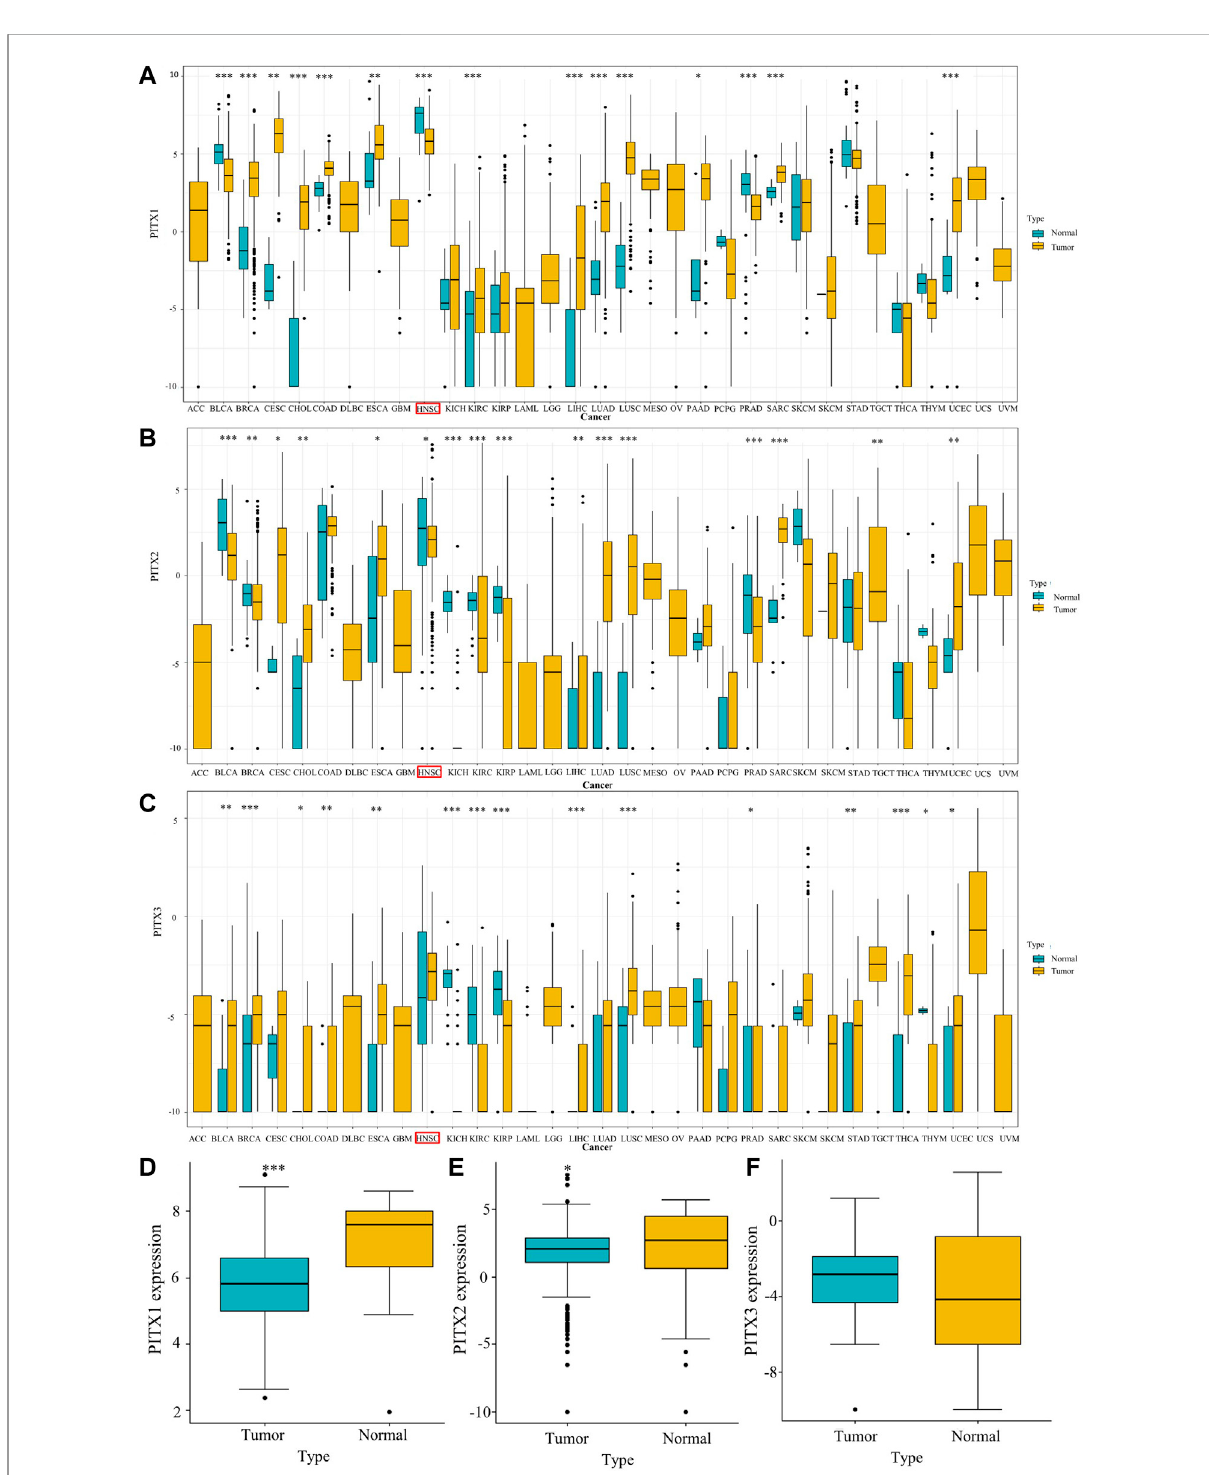
FIGURE 1 Expression of PITX genes in HNSC and normal tissue. (A) PITX1 , (B) PITX2 , and (C) PITX3 expression levels in different tumor types from TCGA. (D) PITX1 , (E) PITX2 , and (F) PITX3 expression difference in unpaired HNSC samples. p ≥ 0.05; *, p < 0.05; **, p < 0.01; ***, p < 0.001. ACC, adrenocortical carcinoma; BLCA, bladder urothelial carcinoma; BRCA, breast invasive carcinoma; CESC, cervical squamous cell carcinoma and endocervical adenocarcinoma; CHOL, cholangiocarcinoma; COAD, colon adenocarcinoma; DLBC, lymphoid neoplasm diffuse large B-cell lymphoma; ESCA, esophageal carcinoma; GBM, glioblastoma multiforme; HNSC, head and neck squamous cell carcinoma; KICH, kidney